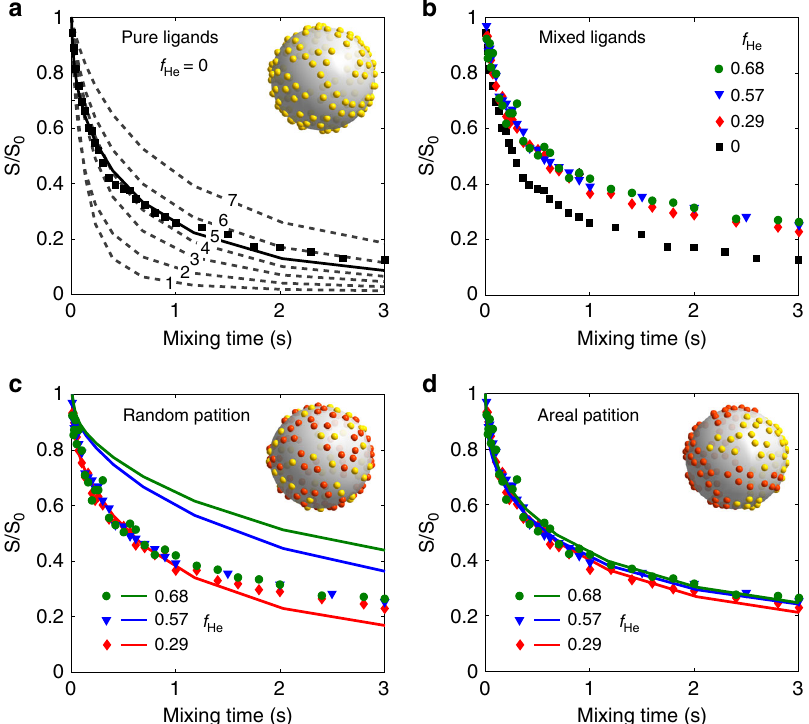
Fig. 2 13 C CODEX results and ligand partition. a The CODEX decay of nanocrystal-ligands complexes with pure ligands based on the signal of 13 C-labeled myristate ligands. The solid and dotted lines are the simulation results of ligand distributions with different numbers (1 – 7) of ligands in one bundle. The solid line corresponds to the scenario of fi ve ligands in one bundle, which has the smallest deviation from the experimental data. b 13 C CODEX decay of complexes with different hexanoate fractions. In c and d , the colored lines are simulations of CODEX decay curves of complexes with mixed ligands in ( c ) random partition and ( d ) areal partition. The yellow dots on the spherical nanocrystal core schematically represent the carboxylate groups of myristate and the red ones stand for the carboxylate groups of hexanoate. The spherical models used in CODEX simulation are 3 nm inorganic core with 135 ligands (the surface ligand density was determined by gas chromatography in Supplementary Table